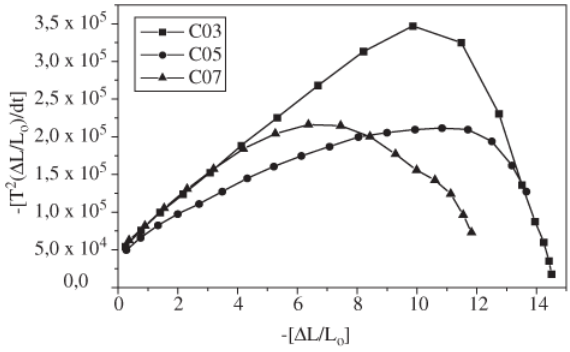
Figure 2. T 2 ( ∆ L/L )/dt vs. ∆ L/L calculated through Bannister’s o o equation. for systems C03, C05 and C07 with a constant heating rate of 5 °C/min.